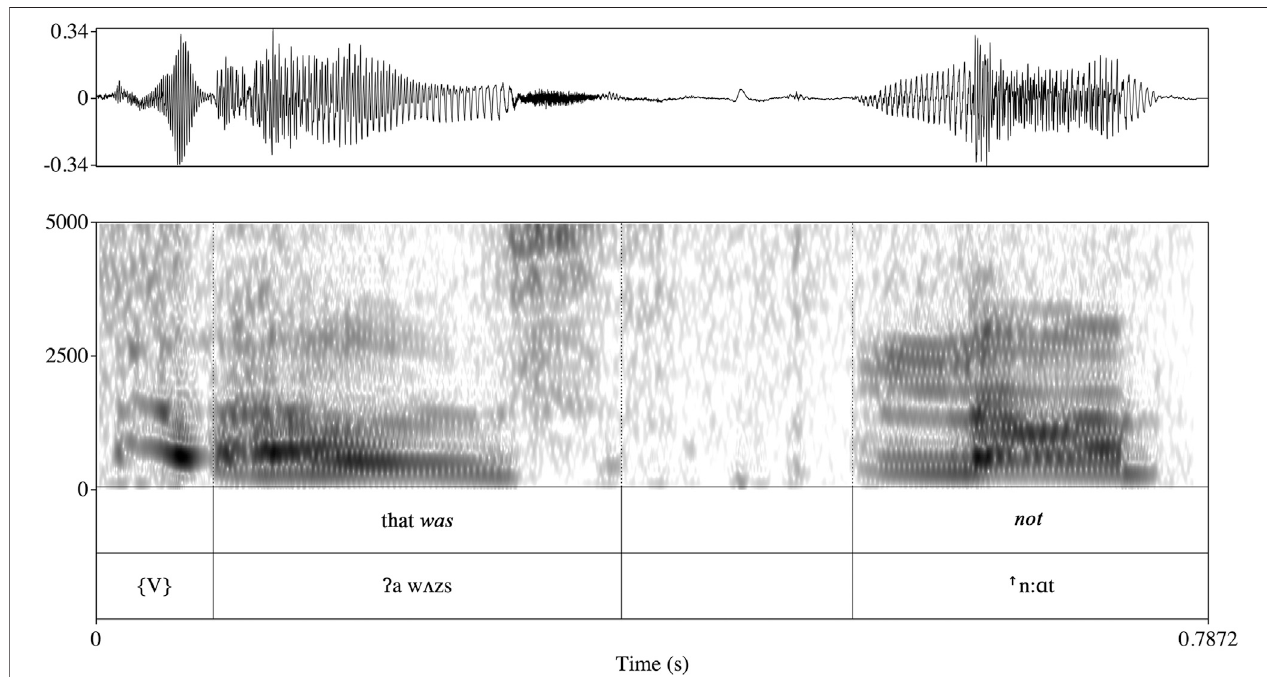
FIGURE4| Aspectrogramofthesuspensionin Extract7 betweenthewords was and not .Notethatanysoundinthespectrogrambetween was and not isdueto environmental noise, as they are outside. This suspension is characterized by silence. {V} is an indeterminate squeaky vowel sound.